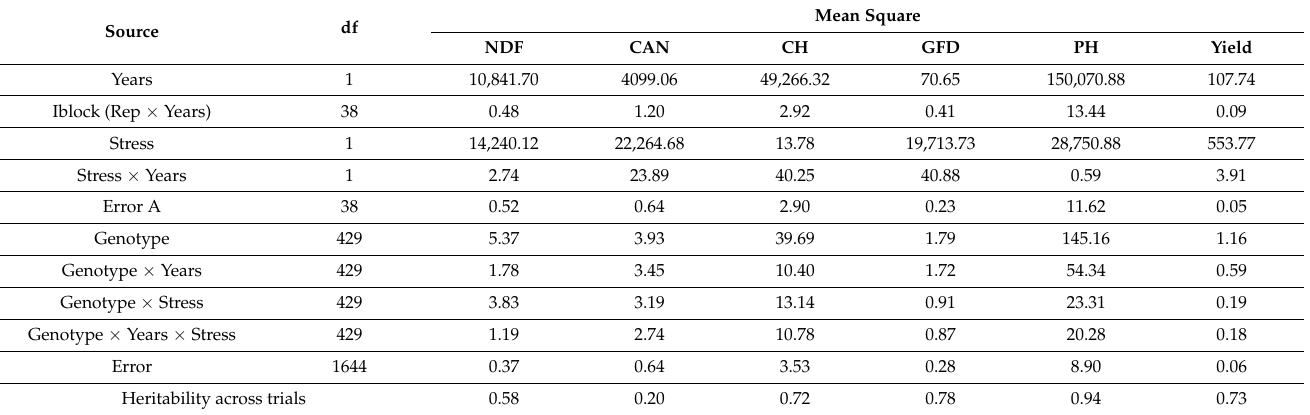
Table 2. The analysis of variance for the Number of Days to Flowering (NDF), Canopy Temperature (CAN), Total Chlorophyll Content (CH), Grain-Filling Duration (GFD), Plant Height (PH), and